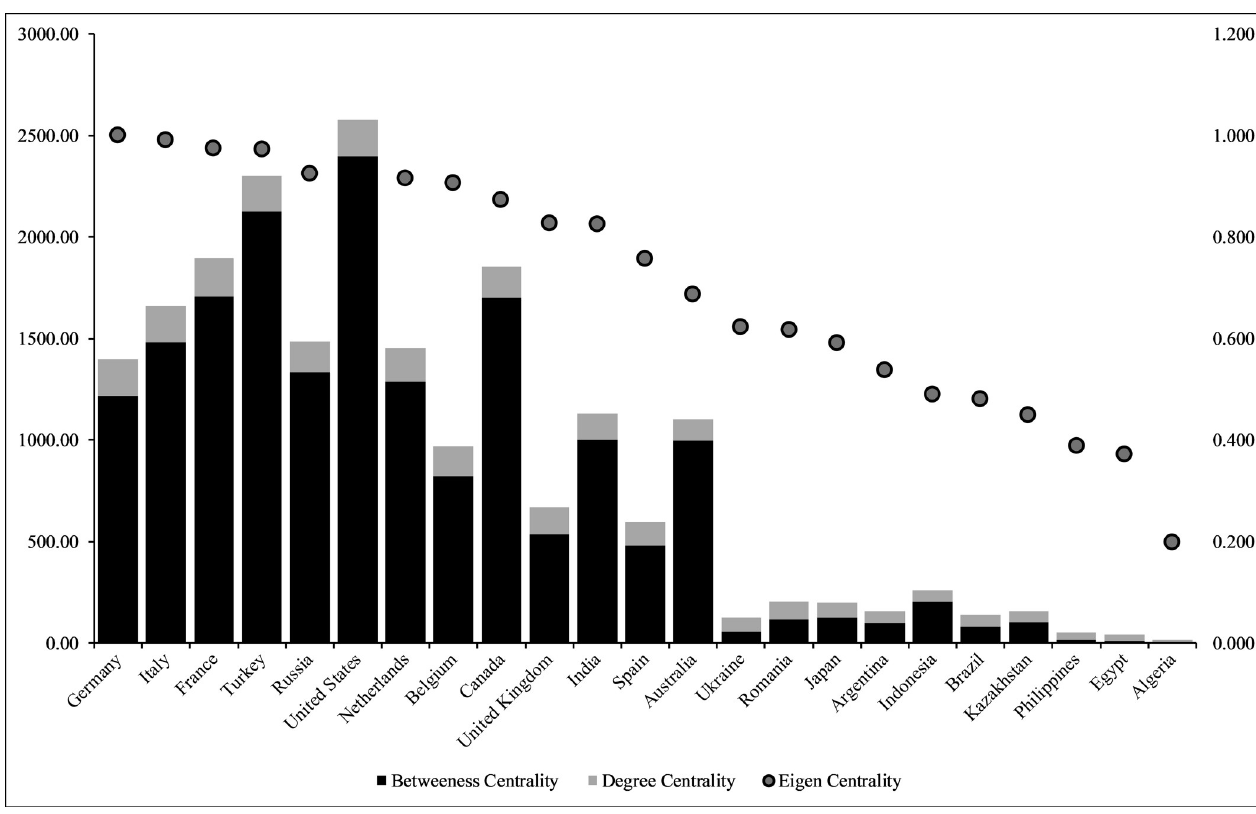
Fig 3. Top 10 countries by centrality